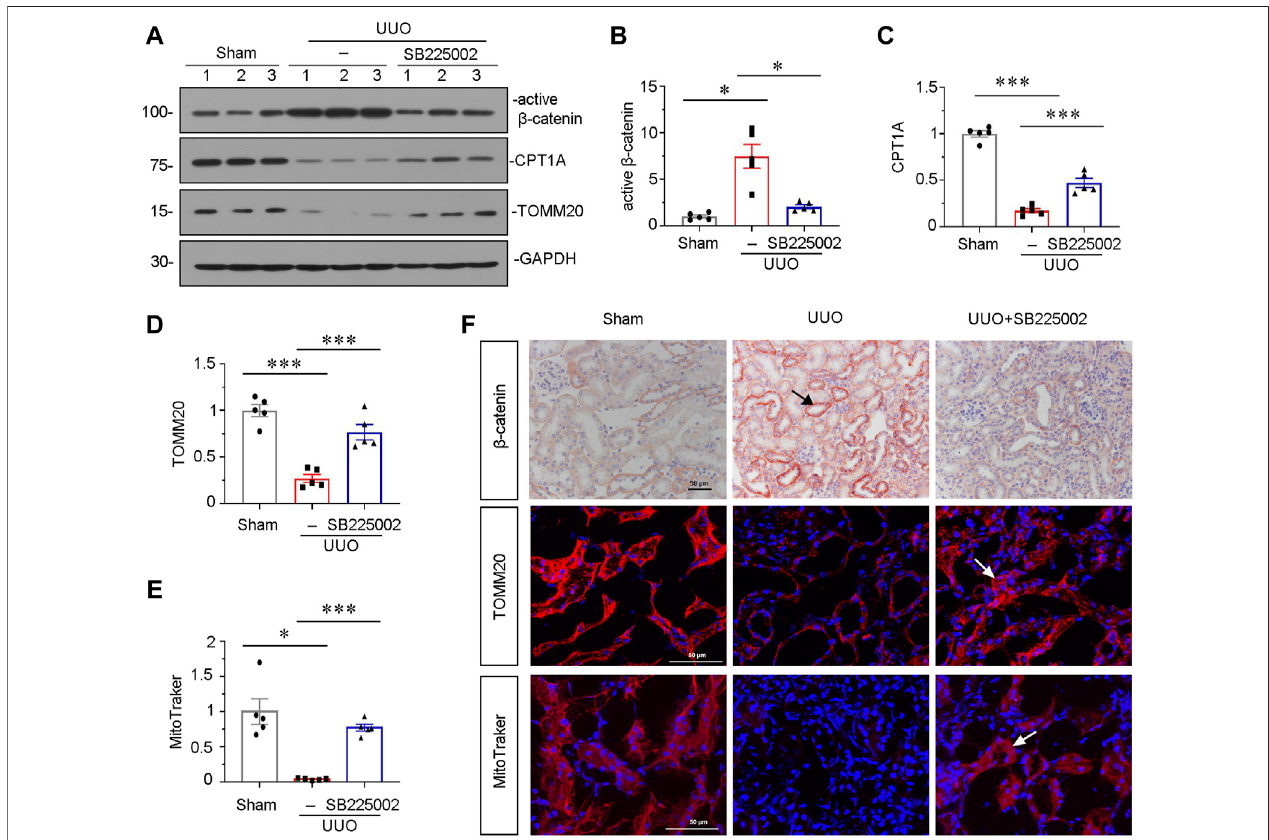
FIGURE 3 | SB225002 inhibits β -catenin signaling and preserves mitochondrial functions in UUO mice model. (A) Protein representative graphs and expressional levels of (B) active β -catenin, (C) CPT1A, (D) TOMM20 are shown. * p < 0.05, *** p < 0.001 n = 5. (E) Quantitative graphs showing MitoTraker staining, which indicated mitochondrial massin three groups. * p < 0.05, *** p < 0.001, n = 5. (F) Representative micrographs showing β -catenin,TOMM20 and MitoTraker stainingin each group, as indicated. Frozen sections were stained for MitoTraker staining and TOMM20 immuno fl uorescence staining. Paraf fi n-embedded sections were stained with β - catenin antibody. Arrows indicate positive staining. Scale bar, 50 μ